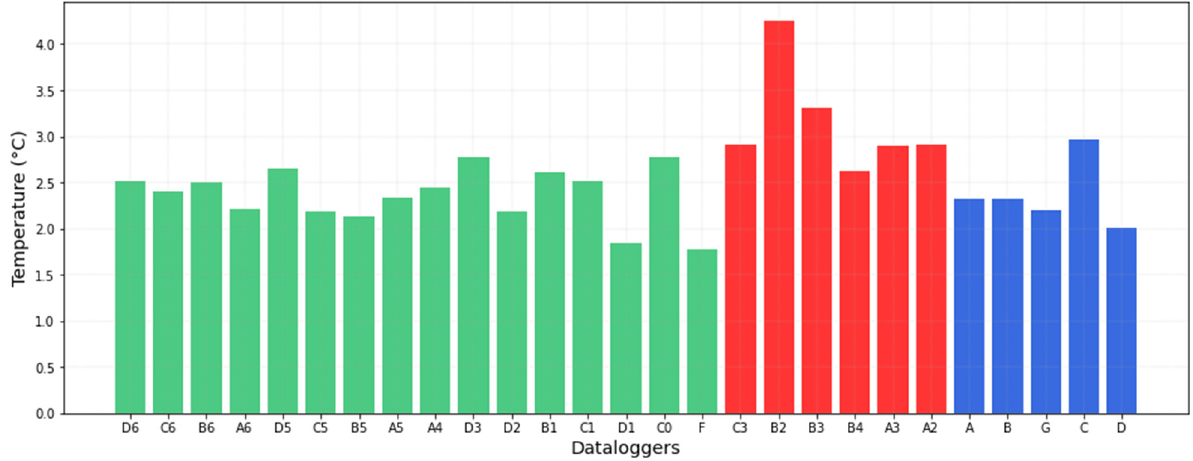
Figure 10. Band width (i.e., separation of security limits) for each data-logger according to EN 15757:2010. Each microclimate